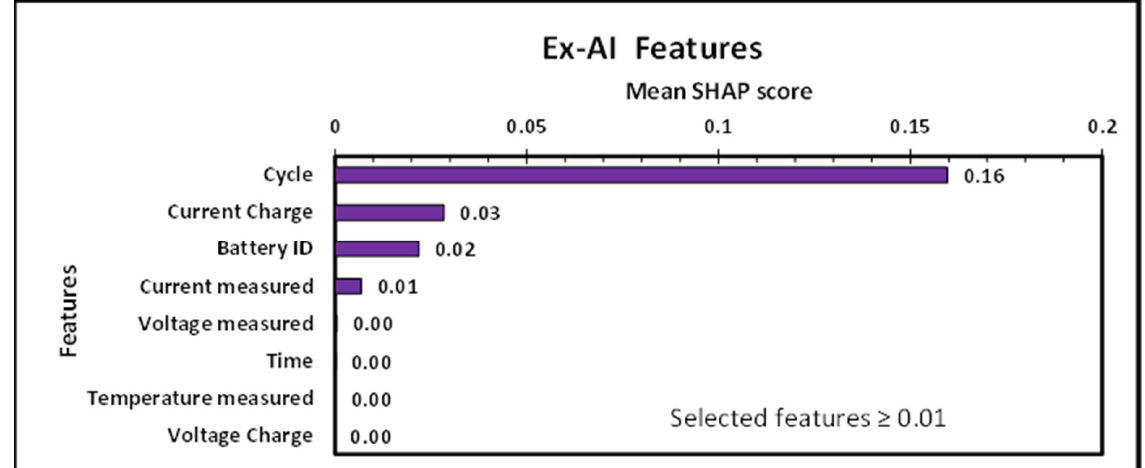
Figure 9. Features selected with Ex-AI model.